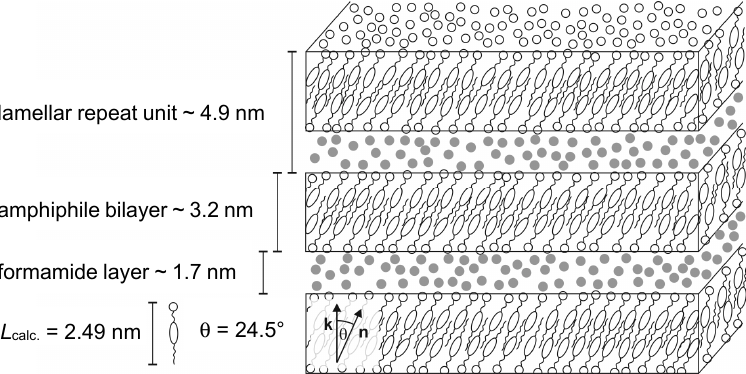
Figure 21. Model of the lyotropic SmC* phase for the system 4 /formamide. The model suggested by Bruckner et al. is based on their measurements shown in Figures 18 and 19 and the length L calc. of the amphiphile calculated by molecular modeling. The sketch corresponds to a sample with 19 wt% of formamide ( • ) at T − T tr = − 10 K. (Reprinted by permission from Springer Nature: